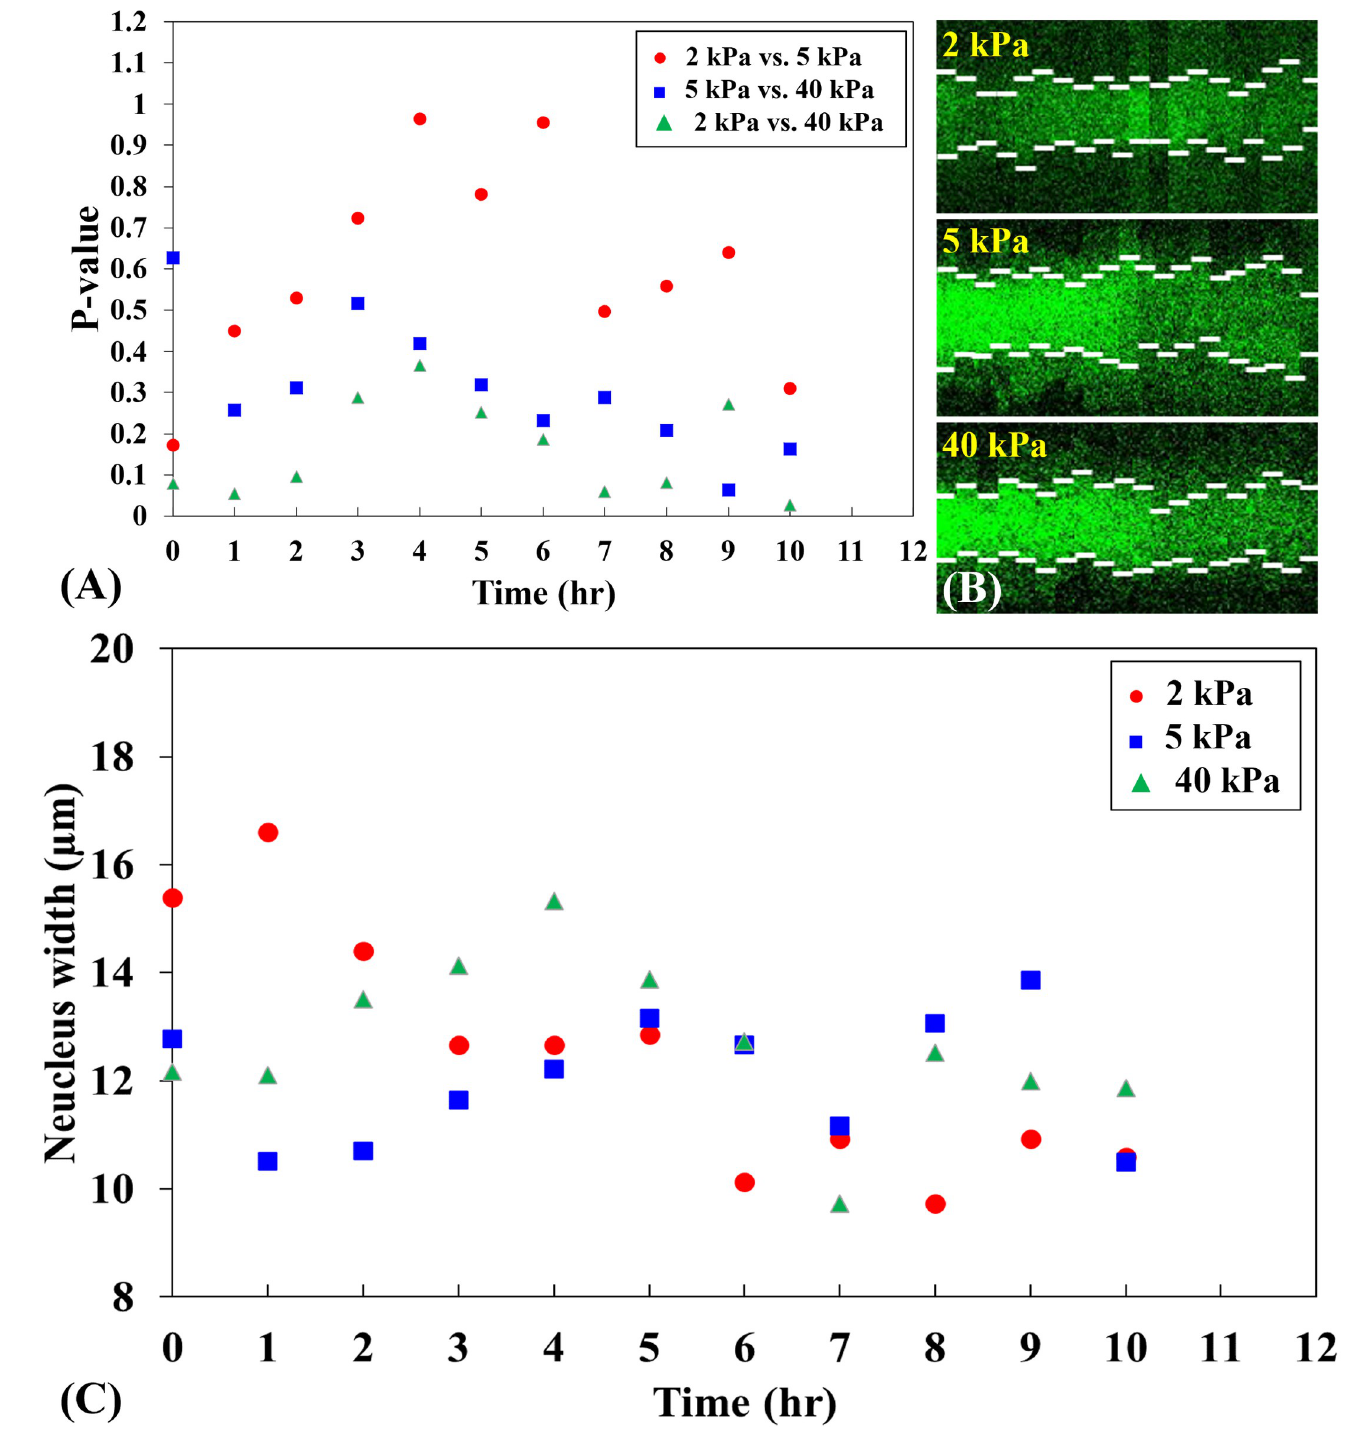
Fig 6. Comparison of the p-values of YAP N/C ratio on different stiffnesses of substrates during the first 10 hours of the spreading process. ( A ) The p-values of the YAP N/C ratio on 2-kPa substrates and 5-kPa substrates (red dots) increased from 0.1725 at 0 th hour to 0.9642 at 4 th hour and decreased to 0.3103 at 10 th hour. The p- values of the YAP N/C ratio between 5-kPa substrates and 40-kPa substrates (blue squares) showed a gradual decrease from 0.6271 at 0 th hour to 0.1637 at 10 th hour. The p-values of the YAP N/C ratio on 2-kPa substrates and 40-kPa substrates (green triangles) maintained stable at the first two hours and rose from 0.0955 at 2 nd hour to 0.3668 at 4 th hour. Next, the p-value declined to 0.0595 at 7 th hour and increased to 0.2727 at 9 th hour. At 10 th hour, the p-value stayed at 0.0262 ( � ). Generally, when the